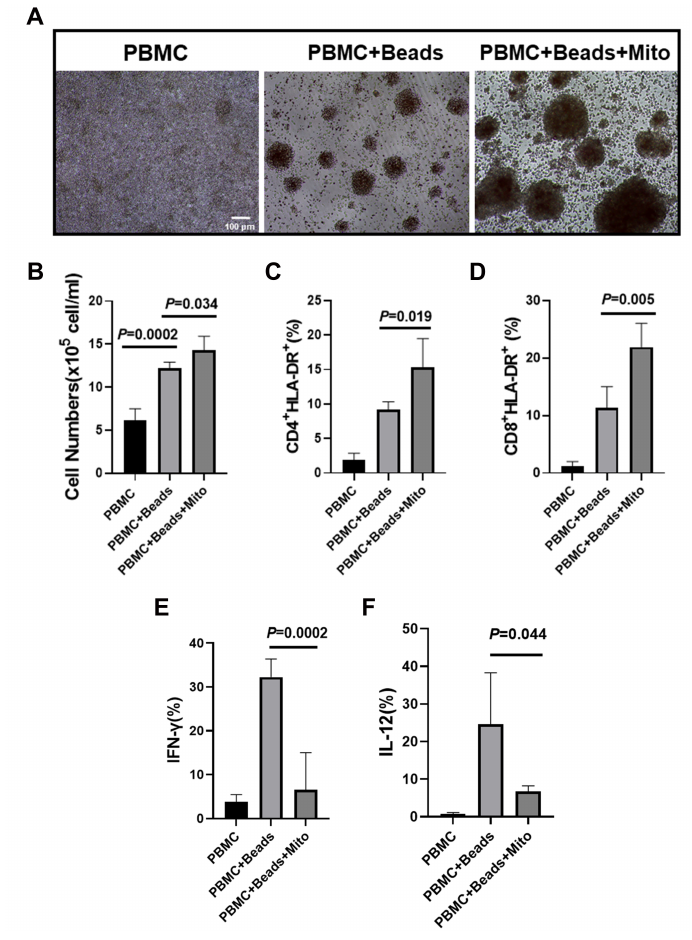
Figure 4. Immune modulation of peripheral blood (PB)-derived mitochondria on PBMC. Health donor-derived PBMC ( N = 4) were treated with PB-derived mitochondria ( N = 4) in duplicate for 3 days in the presence of T-cell activator CD3 / CD28 Dynabeads. ( A ) Phase contrast image show the cluster formation with di ff erent sizes. Untreated PBMC served as control (left panel). ( B ) Increase the PBMC proliferation by PB-derived mitochondria. ( C ) Improve the percentage of the activated CD4 + HLA-DR + T cells by PB-derived mitochondria. ( D ) Improve the percentage of the activated CD8 + HLA-DR + T cells by PB-derived mitochondria. ( E ) Suppression of inflammatory cytokine IFN- γ production in the presence of PB-derived mitochondria at 200 µ g / mL. ( F ) Decrease the level of cytokine IL-12 in CD3 / CD28 Dynabead-activated PBMC after the treatment with PB-derived mitochondria at 200 µ g / mL. Data were given as mean ± SD (standard deviation, N =